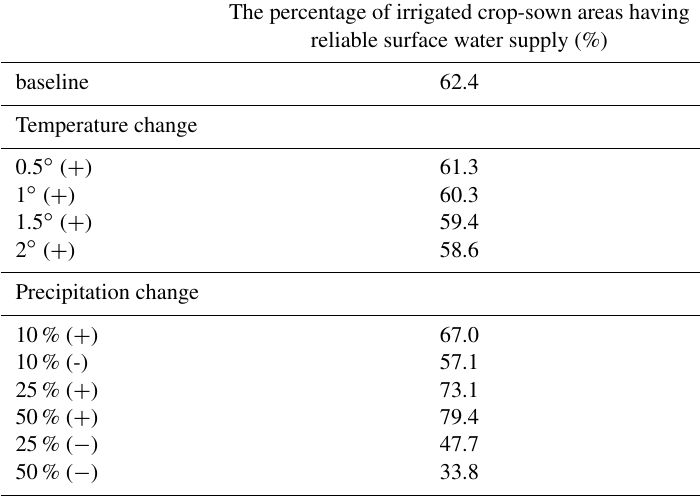
Table 5. Change in supply reliability of surface water irrigation due to climate change in the